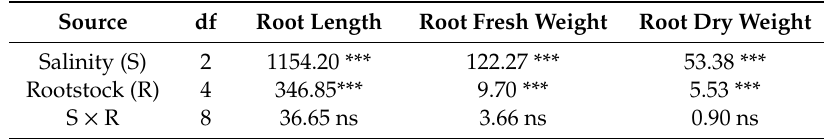
Table 7. Analysis of variance (mean square) of tomato root attributes.